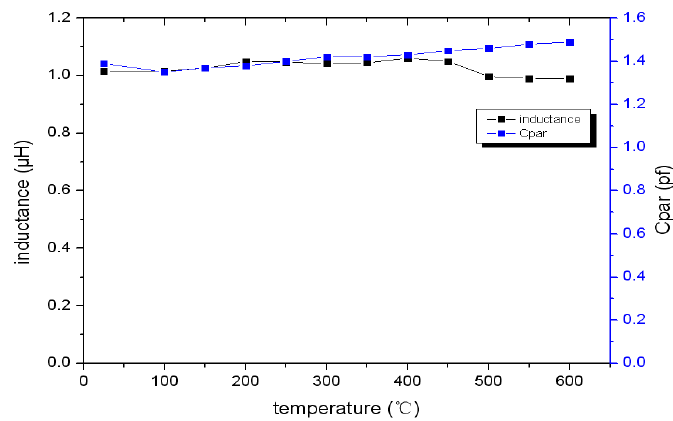
Figure 13. Inductance and parasitic capacitance of the inductance coil versus temperature.